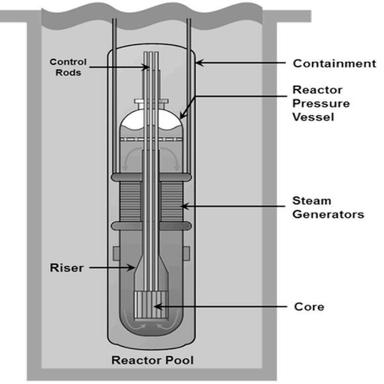
Example SMR module design.